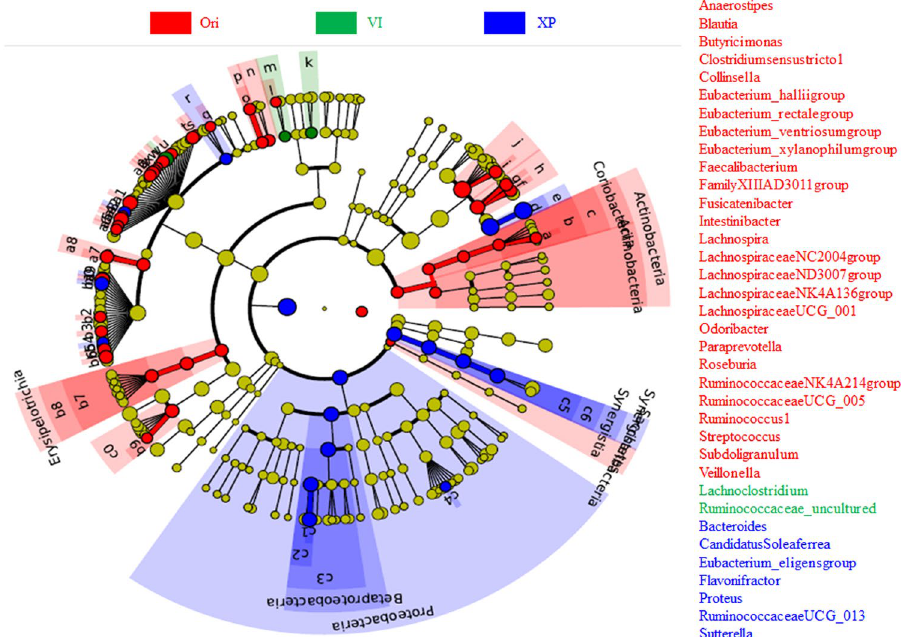
Figure 5. Analysis of different abundant bacterial taxa using LefSe. The bacterial percentage of original fecal samples and fermentation samples was used for LefSe analysis. The p value < 0.05 was identified as significantly different among these groups. Significantly enriched genera are listed on the right side.